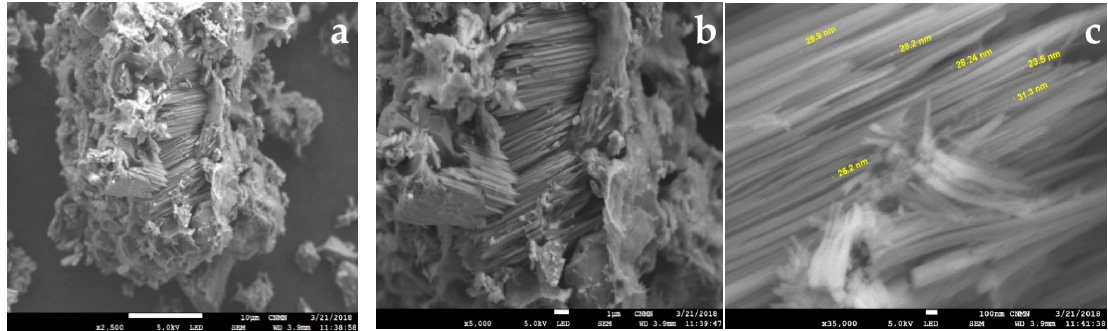
Figure 3. SEM micrographs of zeolite fibers: ( a ) ERIN—×2500, ( b ) ERIN—×5000, ( c ) ERIN—×50,000.